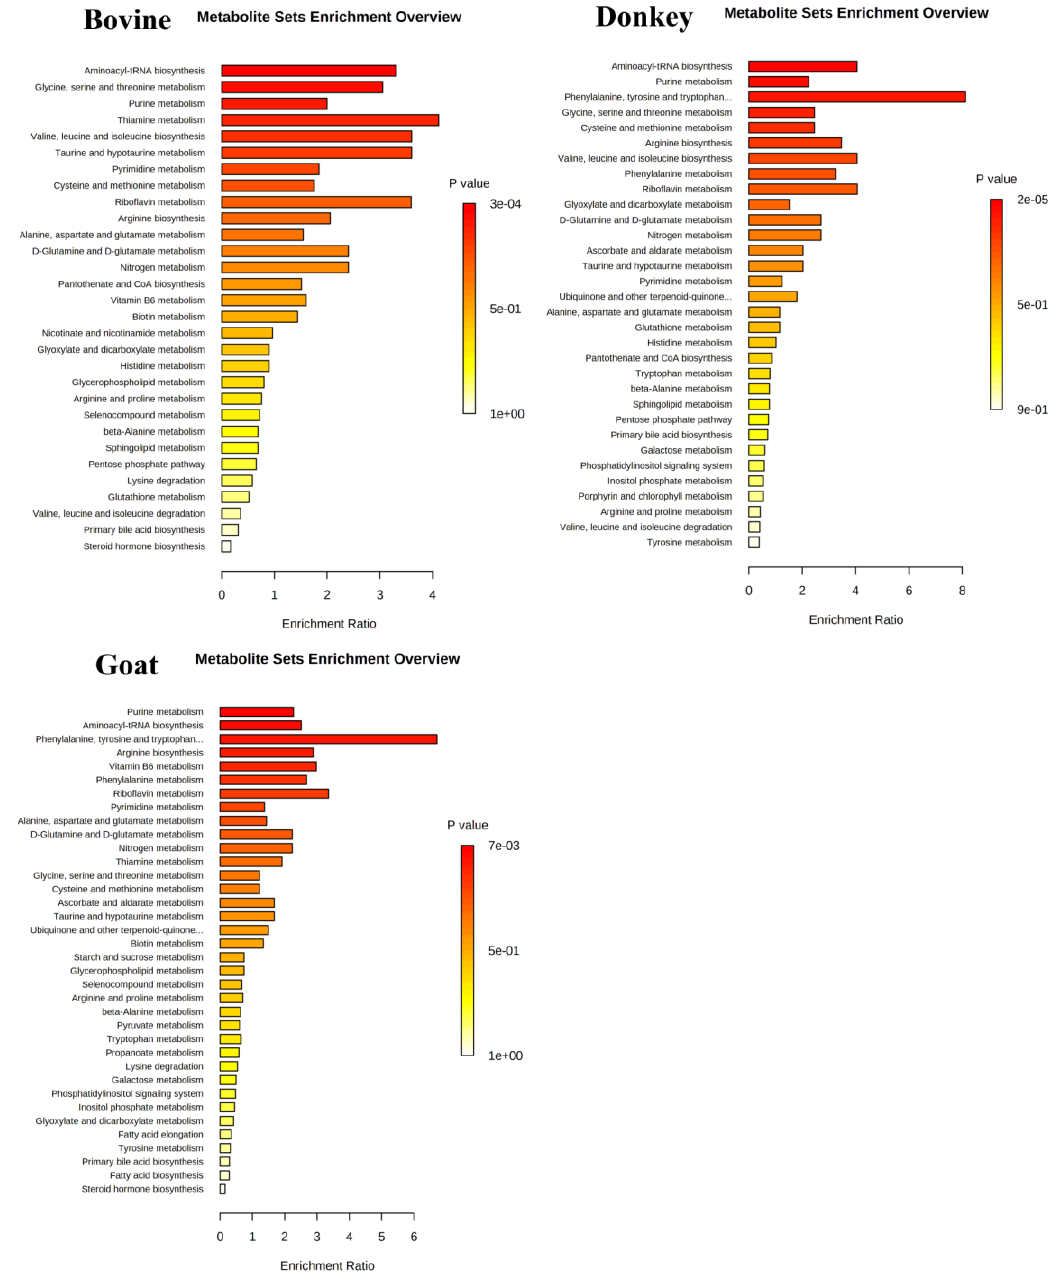
Figure 8. Metabolite Set Enrichment Analysis (MSEA) overview obtained through MetaboAnalyst by plotting -log of p -values from pathway enrichment analysis on the y -axis and pathway impact values from pathway topology analysis on the x -axis. Color intensity (light yellow to red) reflects increasing statistical significance.